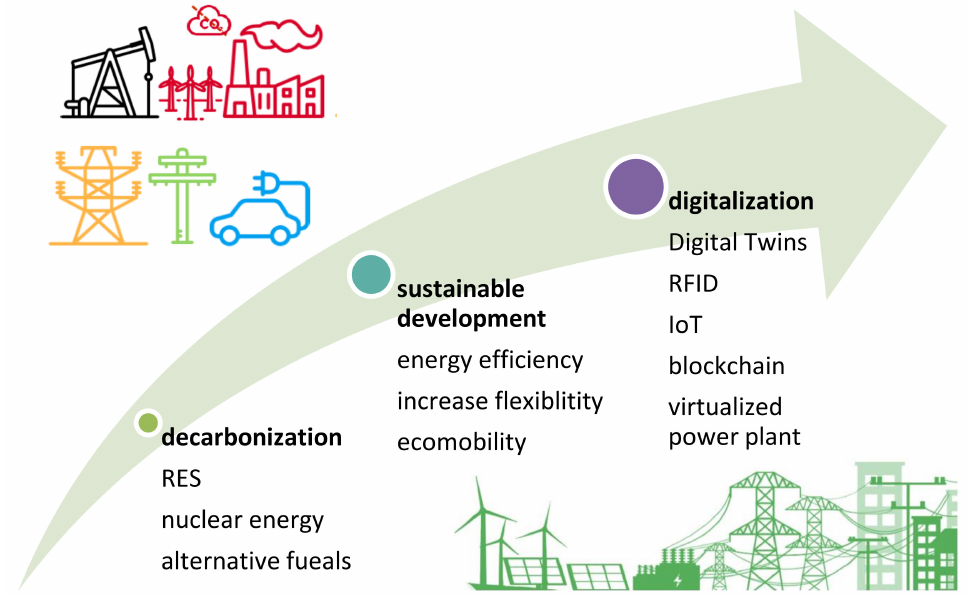
Figure 1. Direction of energy sector development; source: own